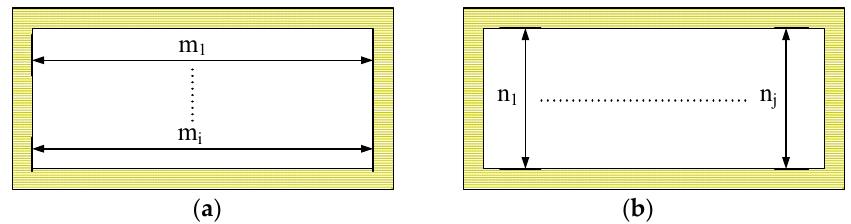
Figure 11. Schematic of waveguide cavity end-face dimension measurement: ( a ) end-face width, ( b ) end-face height.